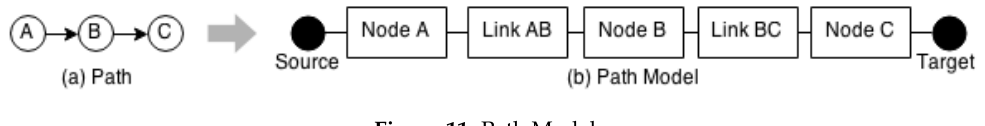
Figure 11. Path Model.